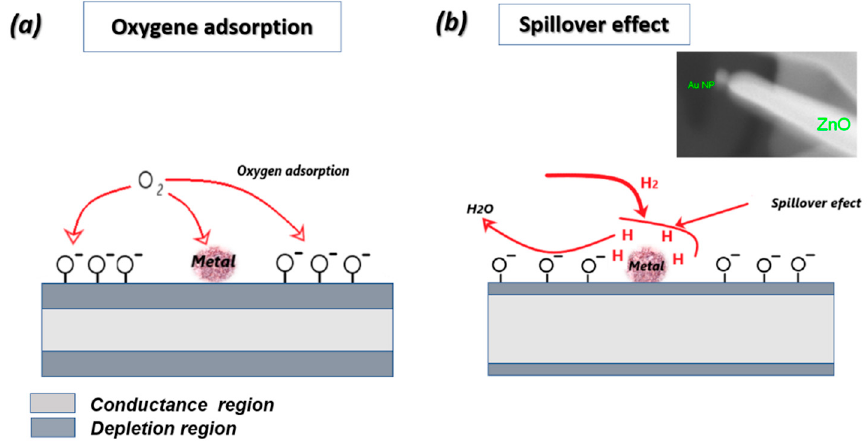
Figure 7. Schematic diagram exemplifying the chemical sensitization mechanism for ZnO/metal under ( a ) Oxygen; ( b ) H 2 gas.